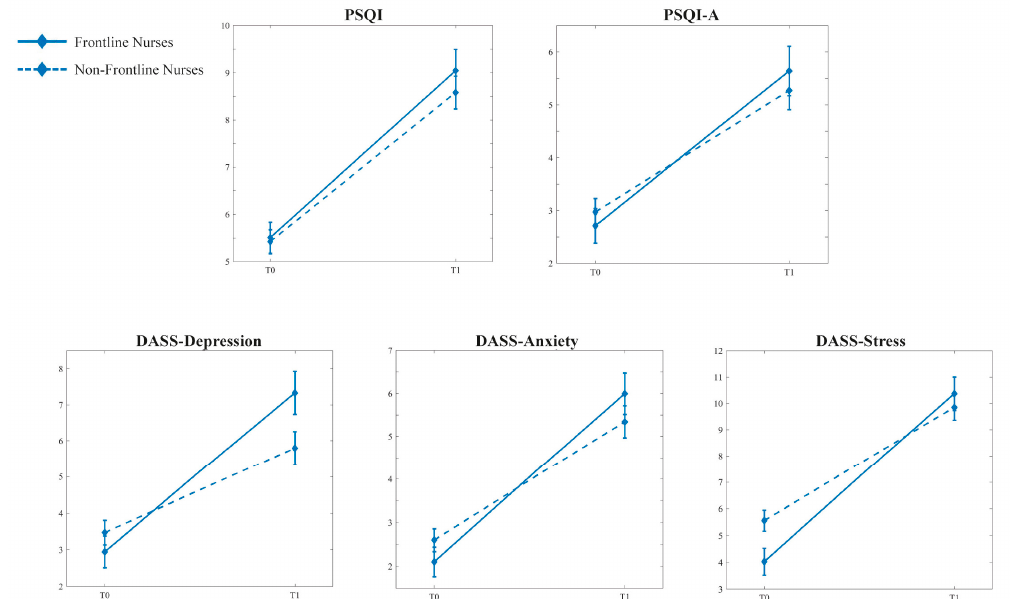
* Asterisks indicate statistical significance ( p ≤ 0.05). ** Asterisks indicate statistical significance ( p < 0.001).